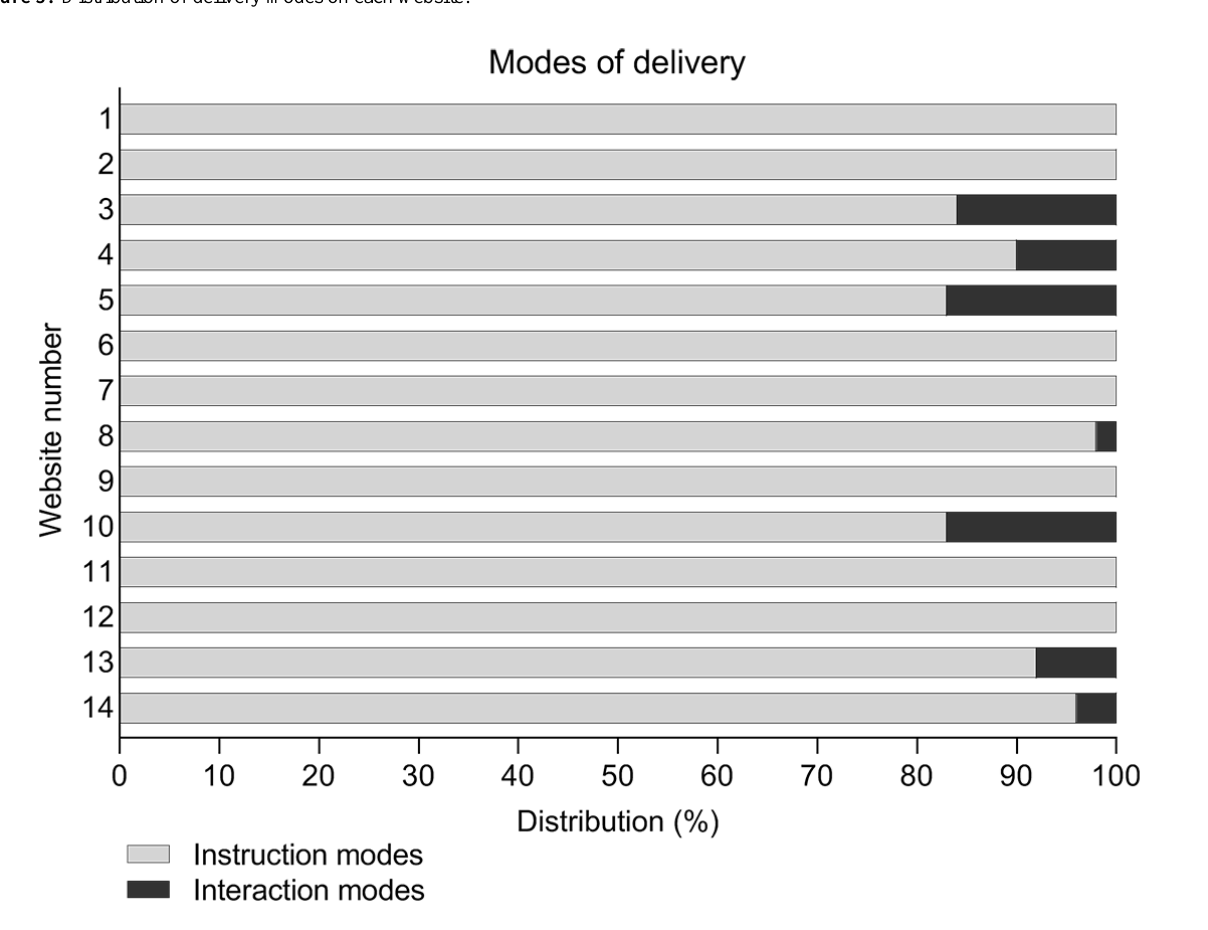
Figure 3. Distribution of delivery modes on each